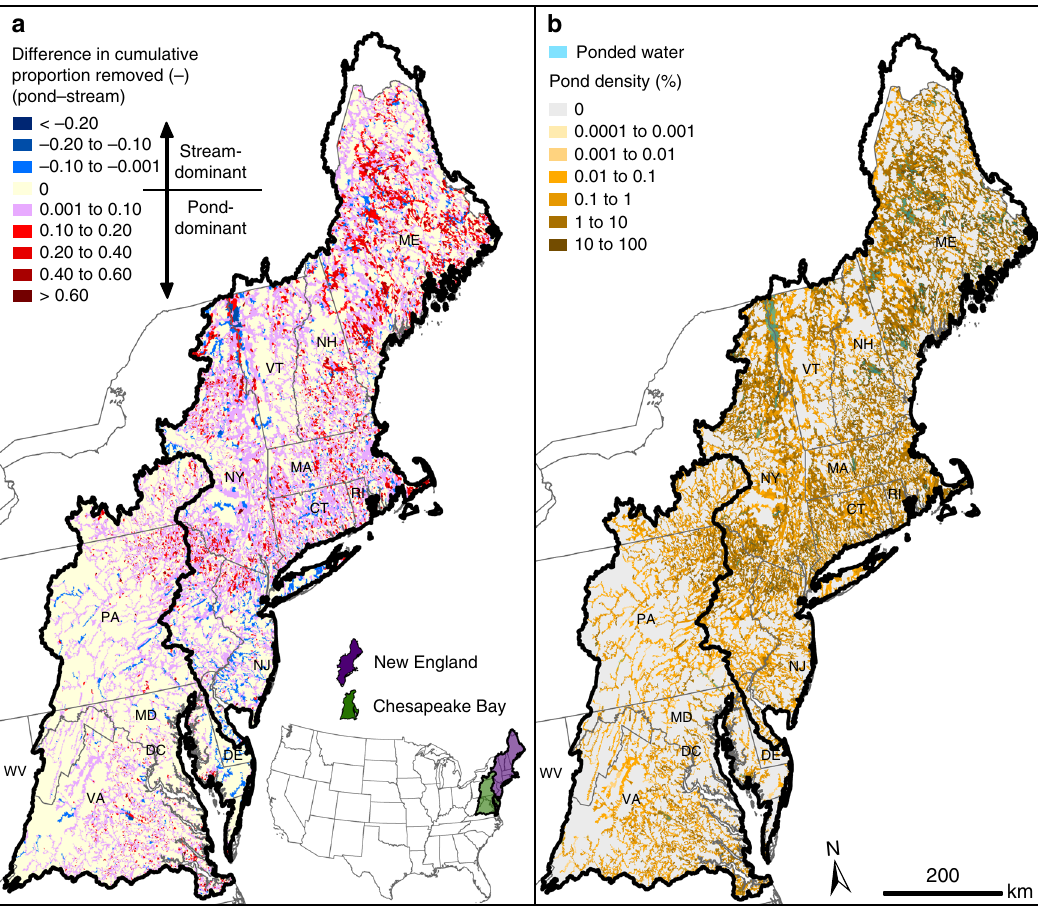
Fig. 1 The relative effect of ponded waters versus streams on nitrogen removal in the Northeastern United States. a Cumulative proportion of total nitrogen removed annually by ponded waters relative to streams (expressed as a difference) throughout the river network, where each stream reach and ponded water catchment is colored. A positive (red) value indicates that nitrogen removal is dominated by ponded waters and a negative value (blue) indicates that nitrogen removal is dominated by streams (see Methods). b Pond density (cumulative upstream pond surface area to cumulative upstream drainage area) throughout the river network. Maps created using model results, data from NHD 35 , and expressions in the